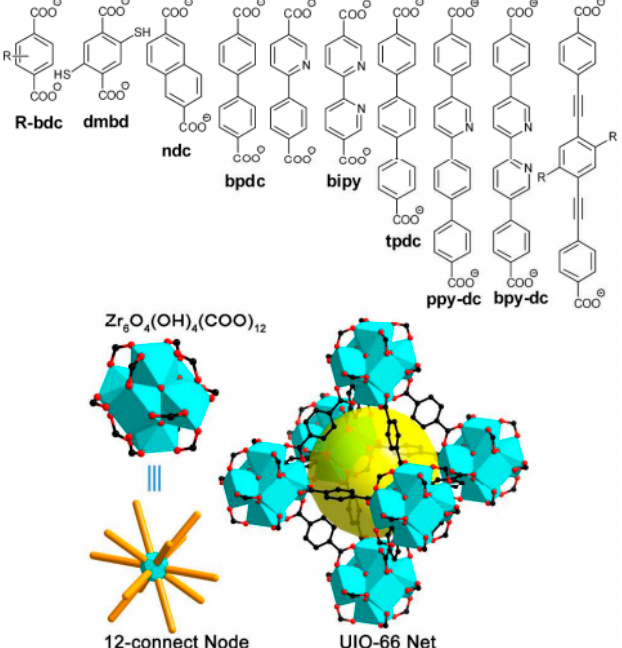
Figure 3. Representative ditopic carboxylate linkers used in the synthesis of the UiO frameworks. SBU with chemical composition of [Zr 6 O 4 (OH) 4 (COO) 12 ] and the UiO-66 octahedral cage. The color scheme is as follows: Zr (blue polyhedra), O (red spheres), C (black spheres). The yellow sphere represent the largest van der Waals spheres that would fit in the cavity without touching the frameworks. Reprinted with permission from [77]. Copyright © 2014, Royal Society of Chemistry. All